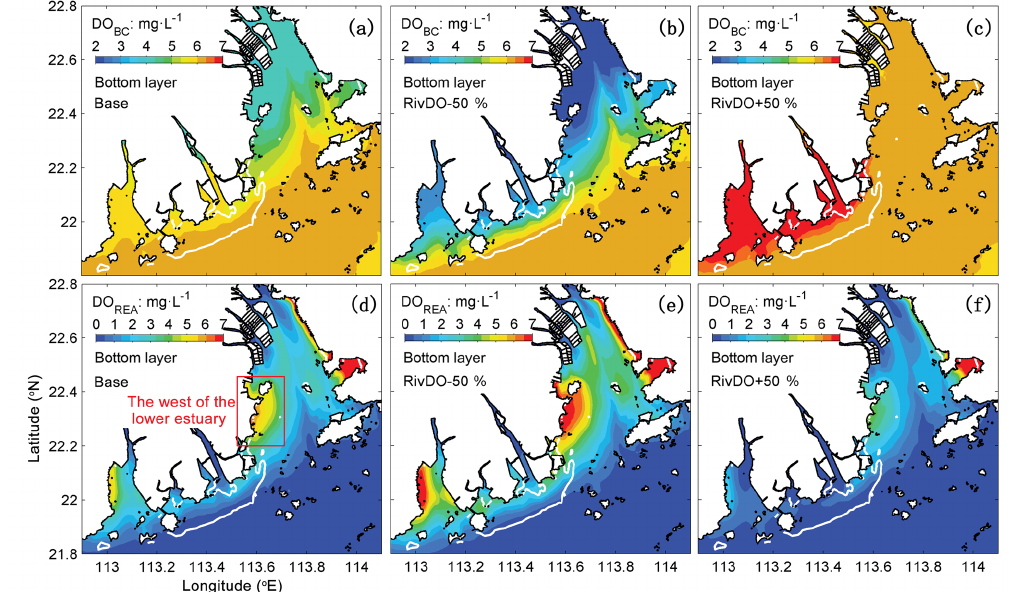
Figure 8. The spatial distribution of DO BC (a, b, c) and DO REA (d, e, f) concentrations at the bottom layer for three DO simulations. The white contour represents the high-frequency zone, and the red box represents the west of the lower